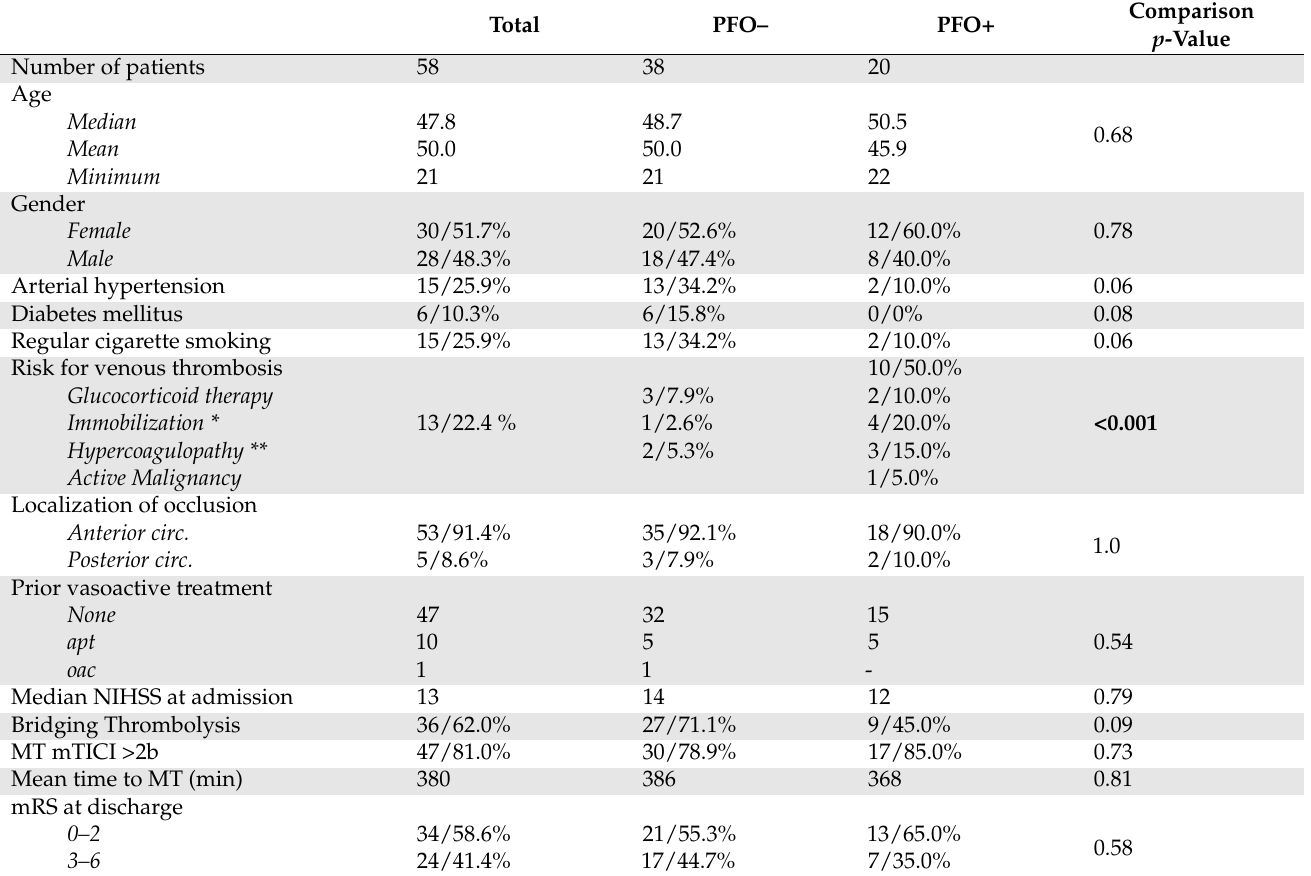
Table 1. Patient characteristics. Subgroups are depicted according to the presence or absence of a patent foramen ovale (PFO+, PFO–). Patient and stroke related data including pre- and postprocedural outcome are depicted. Apt = anti platelet therapy, circ. = Circulation, MT = mechanical thrombectomy, mRS = modified Rankin Scale, mTICI = thrombolysis in cerebral infarction scale, NIHSS = National Institutes of Health Stroke Scale score, oac = oral anticoagulation, Risk for thrombosis = medical, mechanical, or laboratory increased risk of venous thrombosis or history of previous thrombosis, as outlined in the method section, * Immobilization within surgical therapy or long-distance